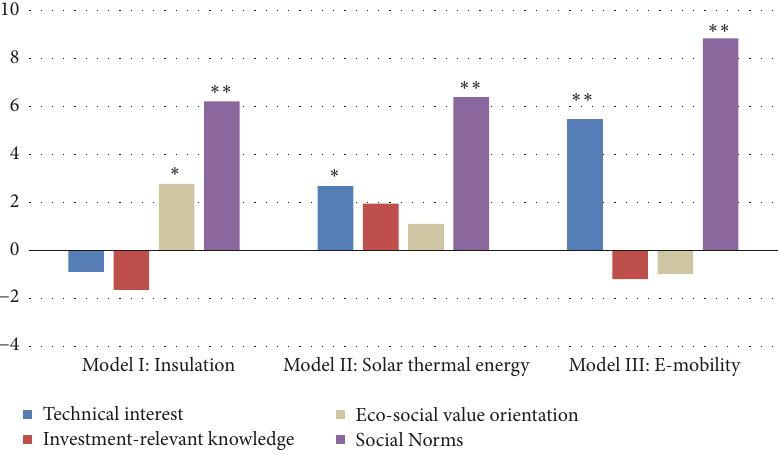
Figure 6: Results from the Estimated Choice Models. The bars show the t-values for each independent variable. The asterisks indicate which variables entered the models significantly ( ∗ p < 0.05 , ∗∗ p < .001